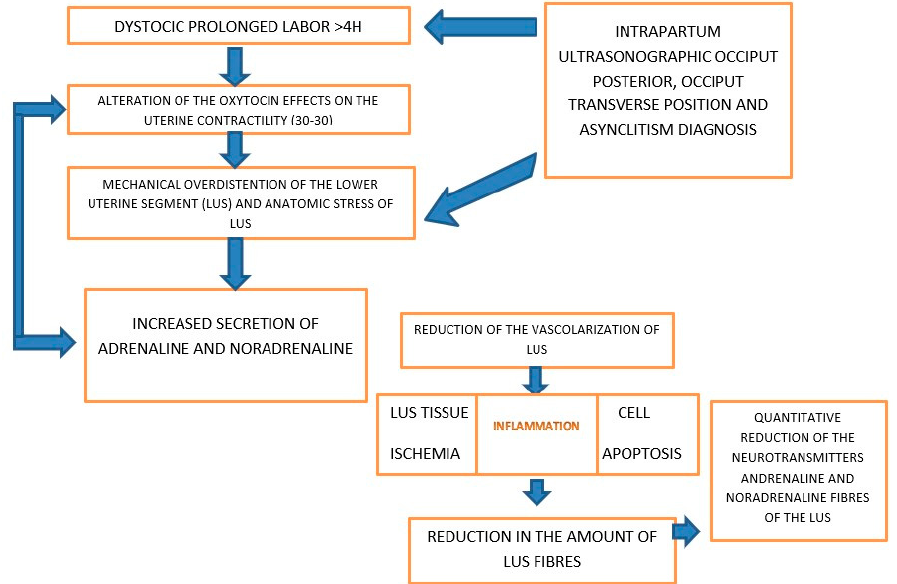
Figure 2. Proposed mechanism of adrenergic and noradrenergic fibers effects in dystocic prolonged labor.